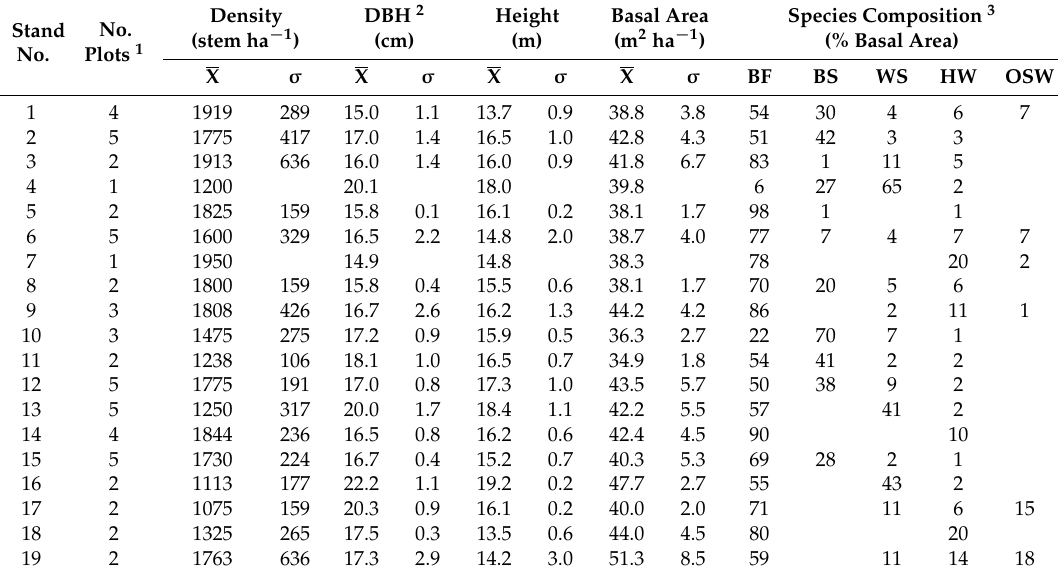
Table 1. Summary of mean (X) and standard deviation ( σ ) characteristics per stand of 57 plots located in 19 stands near Amqui and Causapscal, Qu é bec,